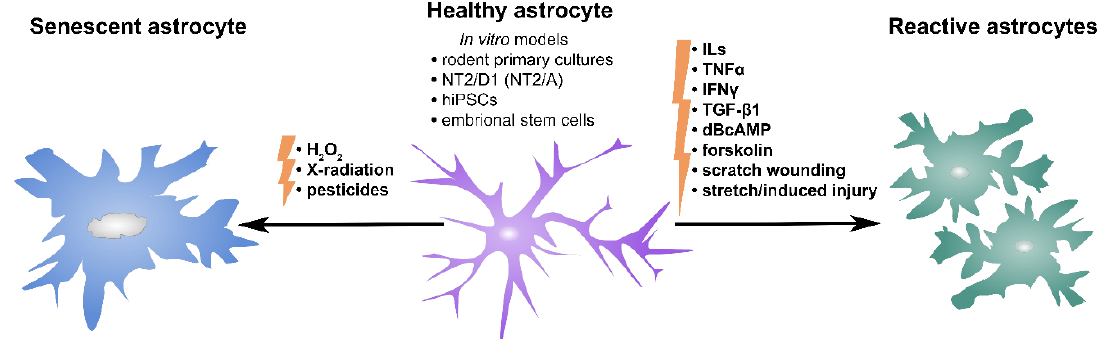
Figure 6. In vitro model systems for the study of astrocyte physiology and pathology. Proposed sources for in vitro models of healthy astrocytes include rodent primary cultures, astrocytes derived from human pluripotent embryonal teratocarcinoma NT2/D1 cell line (NT2/A), human-induced pluripotent stem cells (hiPSCs), and embryonal stem cells. Reactive and senescent astrocyte pheno- types can be induced by applying different stimuli on healthy astrocyte; ILs—interleukins: TNF α — tumor necrosis factor α ; IFN γ —interferon γ ; TGF- β 1—transforming growth factor β 1; dBcAMP— dibutyryl cyclic AMP; H 2 O 2 —hydrogen